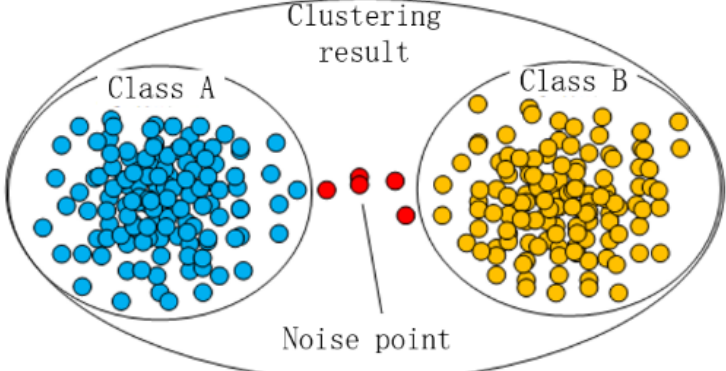
ff ect of noise points on Euclidean clustering Figure 5. Effect of noise points on Euclidean clustering algorithm. Figure 5. E